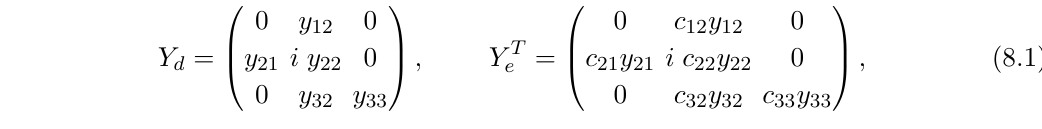
Table 5 . The 1 σ HPD range for δ d MSSM